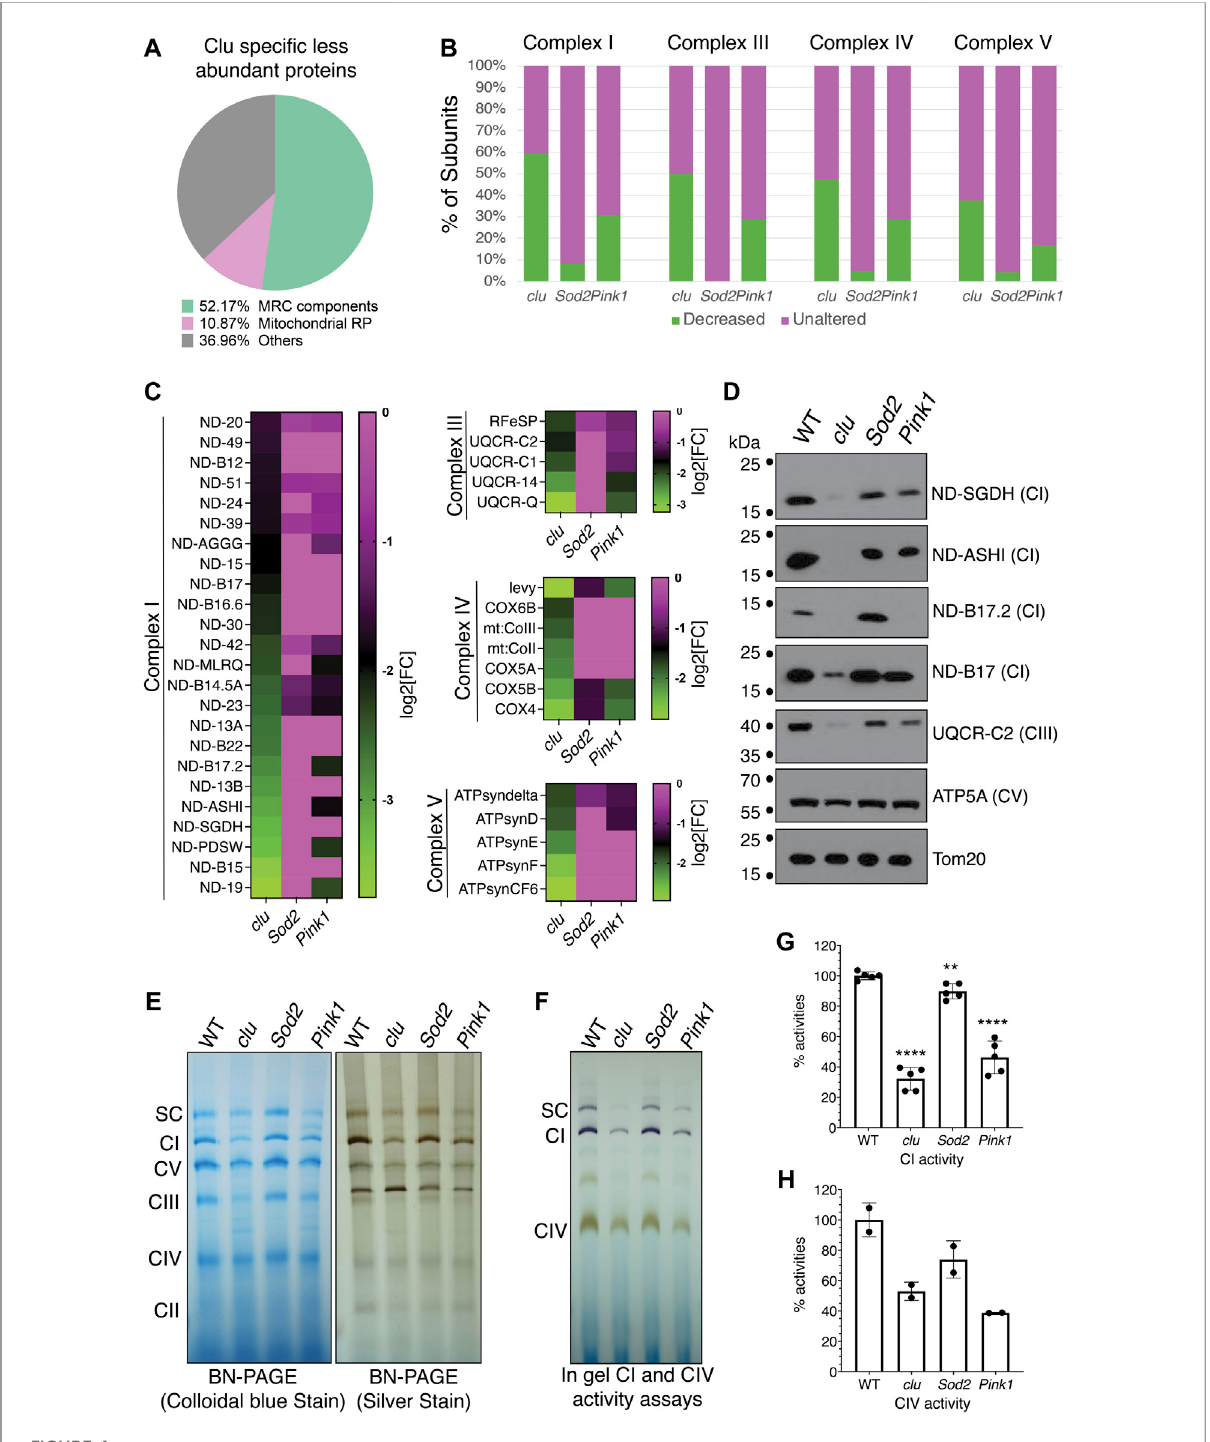
Mitochondrial respiratory chain proteins are greatly decreased in clu mutants. (A) A pie chart showing clu speci fi c less abundant proteins in different categories as percentage of the whole [total = 92 (Figure 2A)]: Mitochondrial Respiratory Chain (MRC) components, Mitochondrial Ribosomal Proteins (Mitochondrial RP) and Others. (B) Bar graph showing the number of subunits, in percentages, from each entire MRC are either decreased (in green) or remain unaltered (in magenta). (C) Heat maps showing the levels of affected individual MRC proteins of different complexes in clu , Sod2 , and Pink1 mutants. The proteins chosen are decreased in clu mutants. Color coded scale bars (green: less abundant and magenta: unaltered) are representing the log2[Fold Change] of individual protein in each mutant compared to wild type. (D) Western blots showing thelevelsofrepresentativeproteinsin clu , Sod2 ,and Pink1 .Tom20wasusedasaloadingcontrol. (E) Proteinsfromisolatedmitochondriawererunto